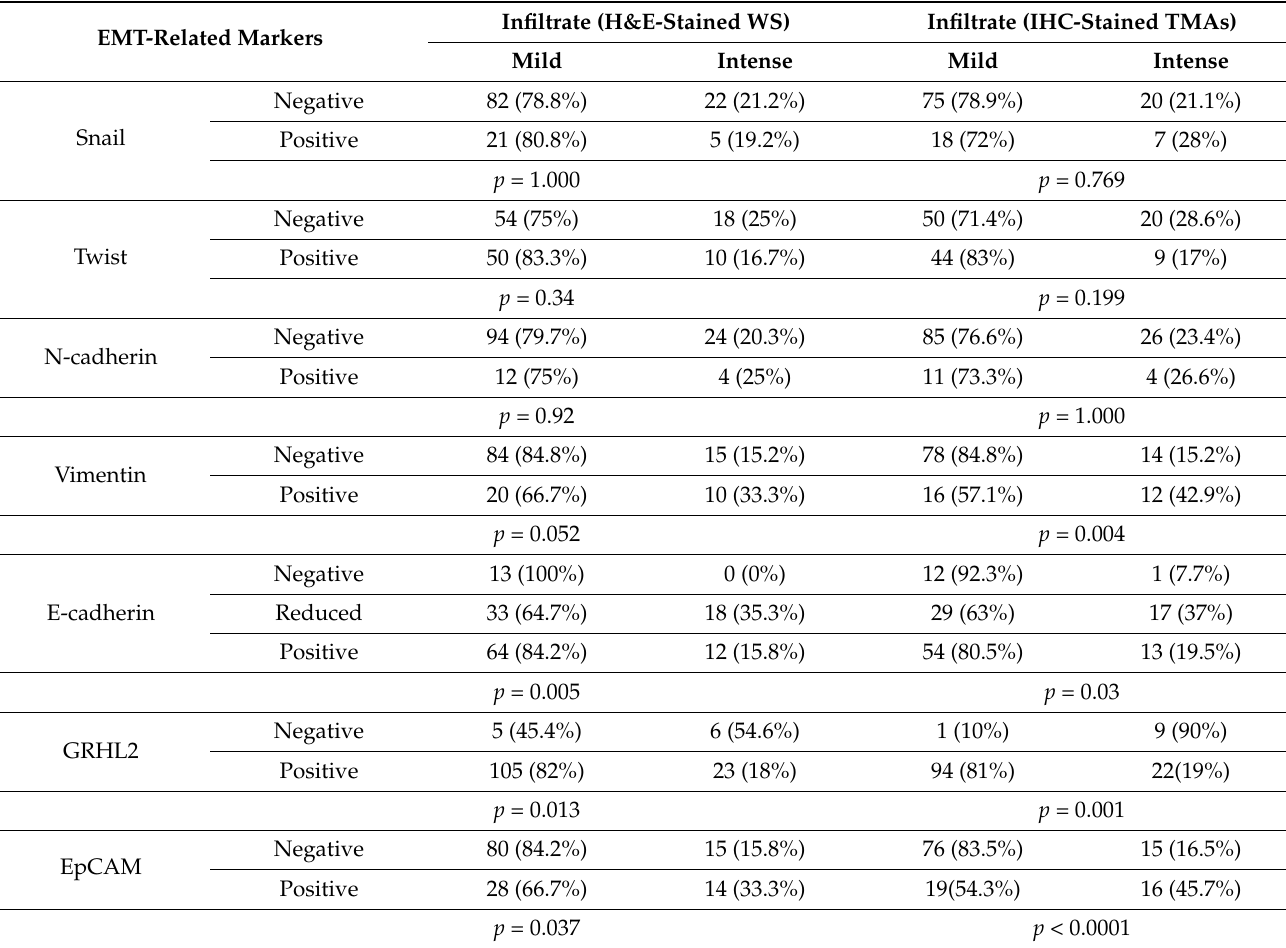
Table 6. Association between the levels of protein expression of EMT-related markers and the degree of inflammatory infiltrate. EMT-Related